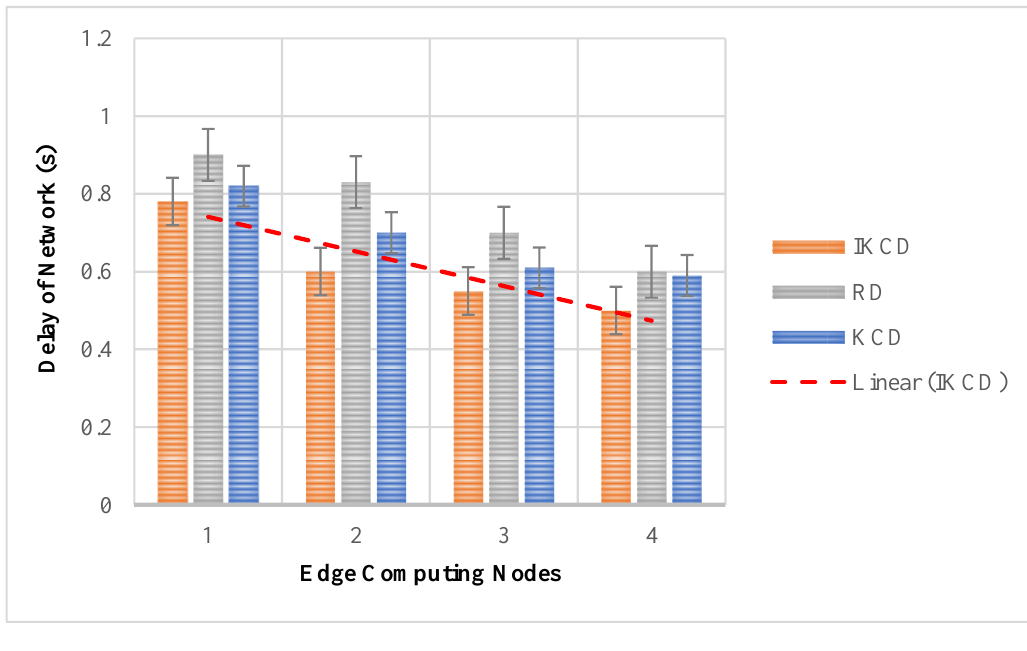
Figure 12. Changes of network nodes based on edge computing.